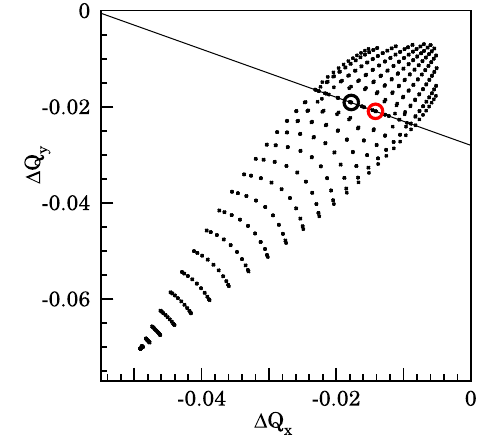
FIG. 12. Space charge tune-spread. The solid line is the third order coupled resonance Q x þ 2 Q y ¼ 19 . The circles enclose the tunes of the two resonant orbits shown in Fig. 13(a).